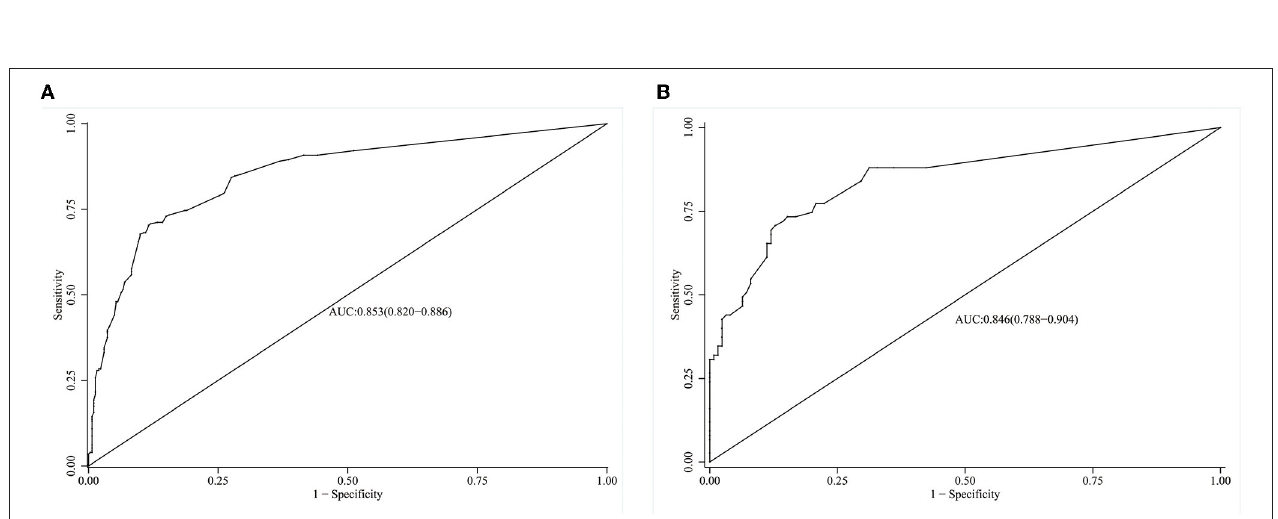
FIGURE 3 | ROC curves of the model in the training and validation group. (A) ROC of the model in the training group. (B) ROC of the model in the validation group.